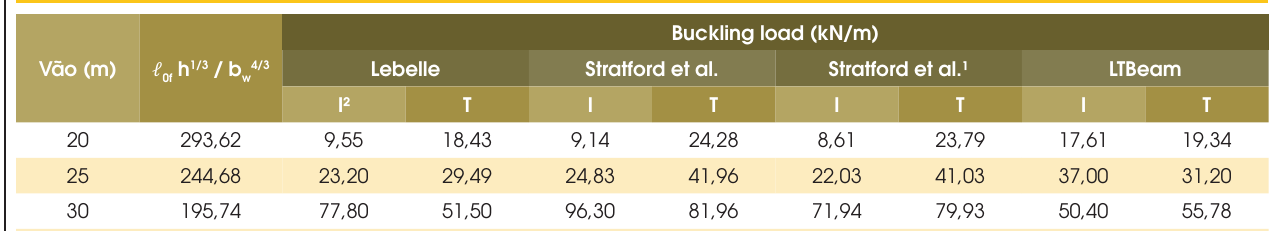
Table 5 – Buckling load of rectangular beams for span